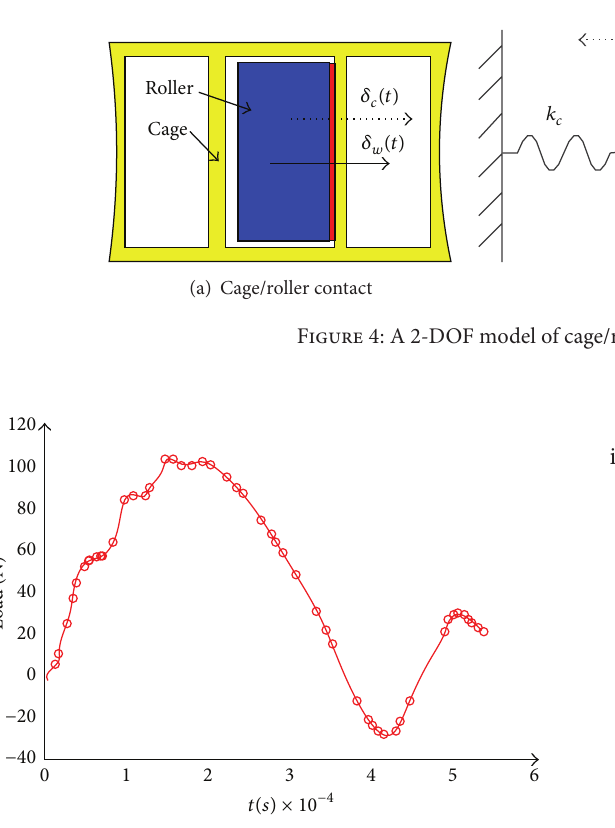
Figure 5: Demonstration on variation trend of cage-roller contact